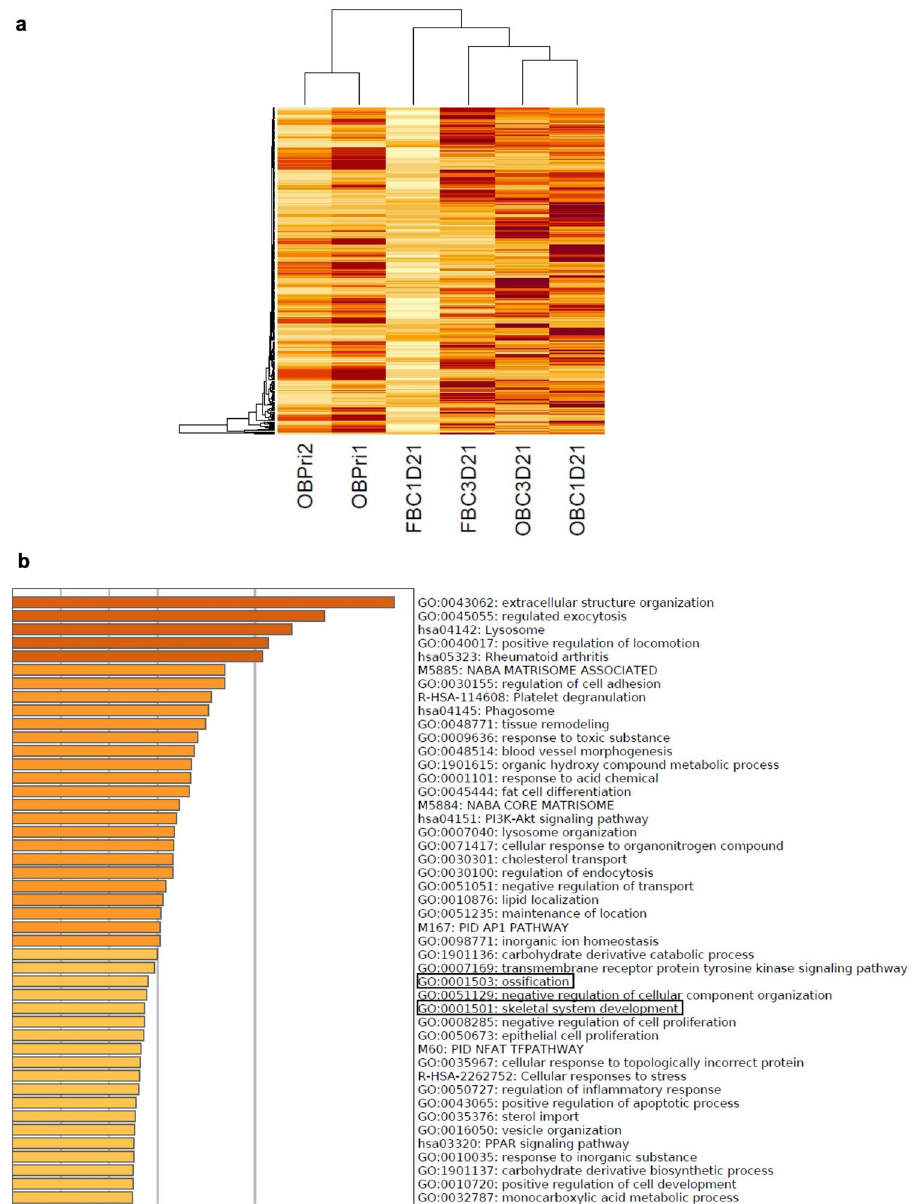
Figure 6. RNA-seq was used to investigate mRNA expression on day 21 in osteogenic media and fibroblast media. Profile of global mRNA expression during osteogenic transdifferentiation. Cells from 2 healthy controls (FIB) were cultured in osteogenic medium (OG) and fibroblast medium (Fib) for 21 days. ( a ) Heatmap shows an overview of significantly upregulated genes in osteogenic medium compared to fibroblast medium indicating separate clustering of cells in fibroblast medium on day 21 (middle 2 columns) compared to cells in osteogenic medium on day 21 (right 2 columns) and primary osteoblasts (left 2 columns). ( b ) Gene ontology results show significant changes in upregulation of gene expression related to bone